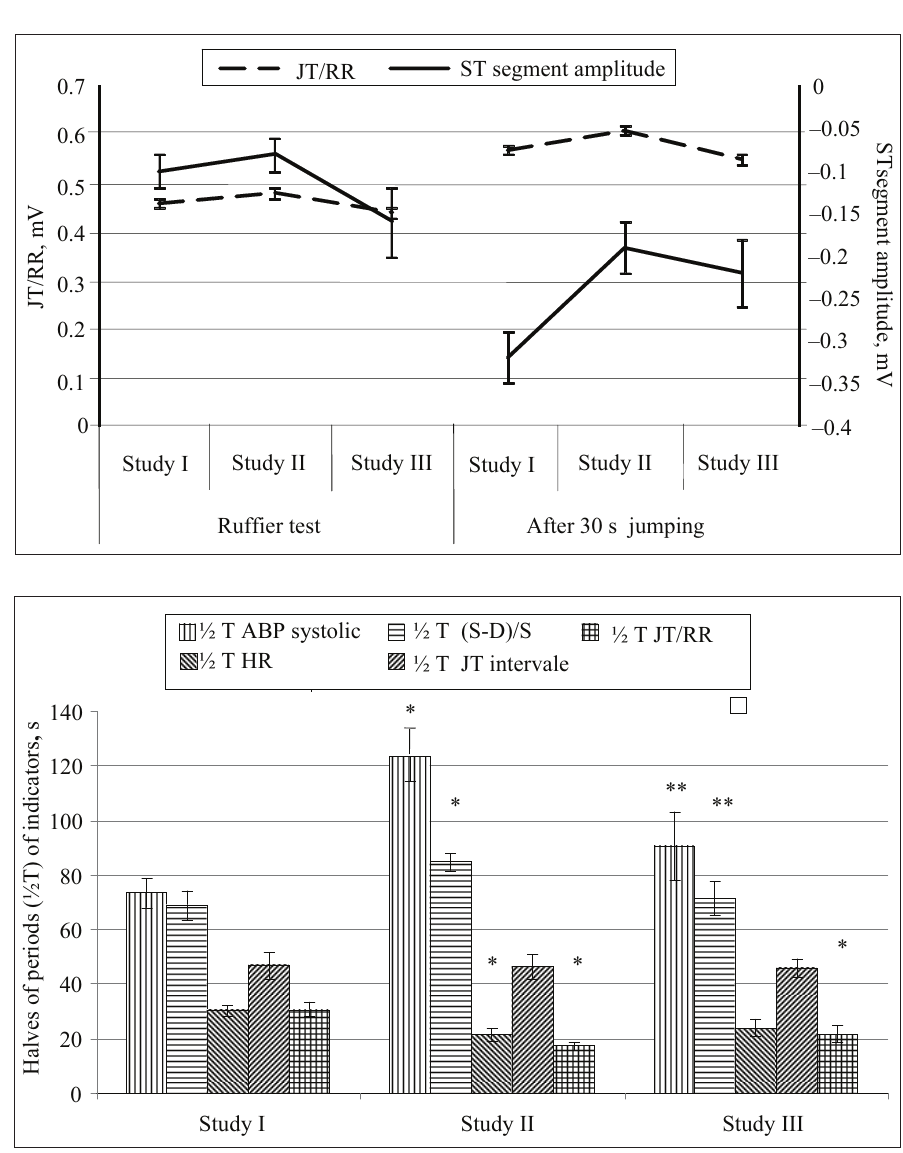
Figure 2. JT‑interval, ST‑ segment depression values at the end of modified Ruffier functional test and after 30 s vertical jumps